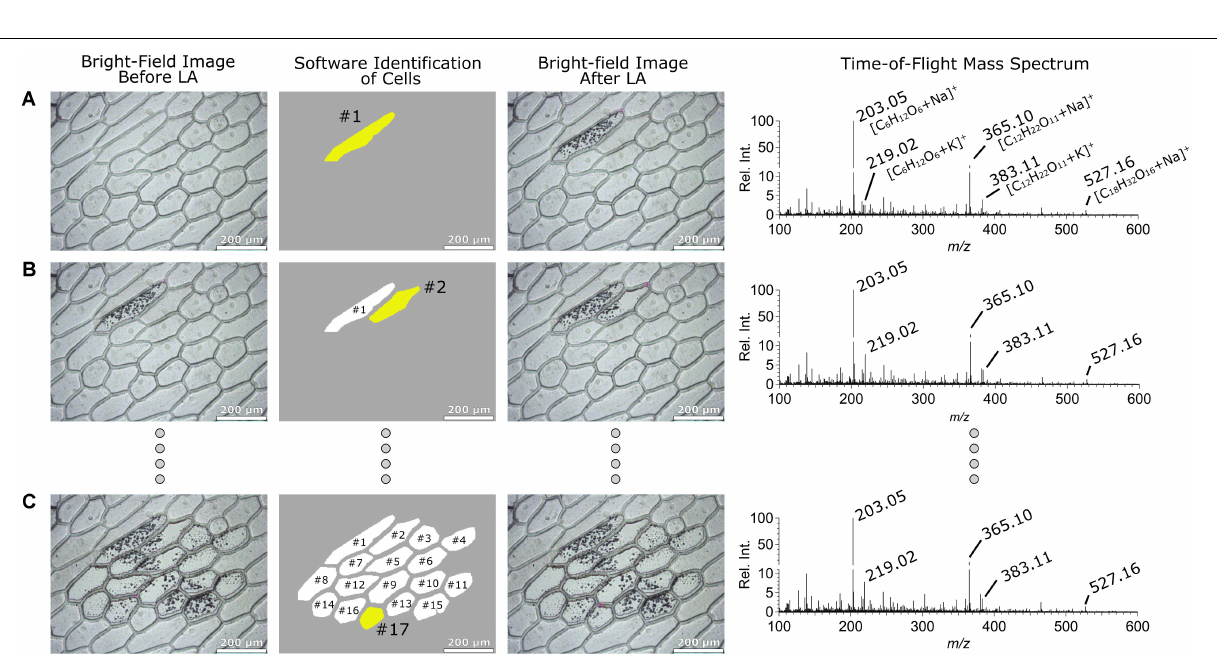
Frontiers in Plant Science |